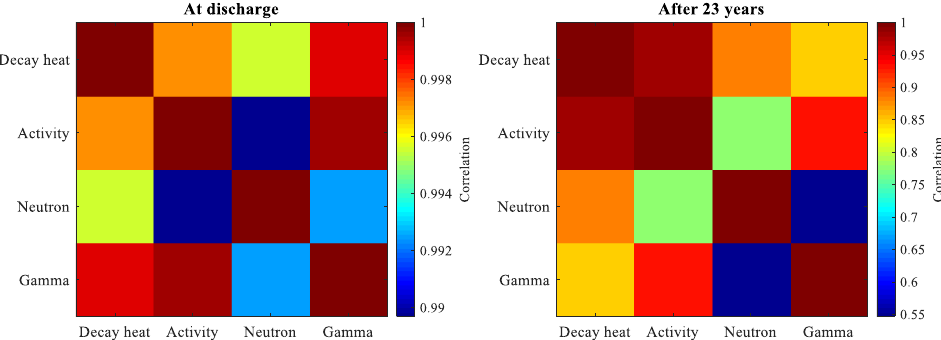
Figure 6. Correlation matrix of the source terms for the 15 x 15 fuel